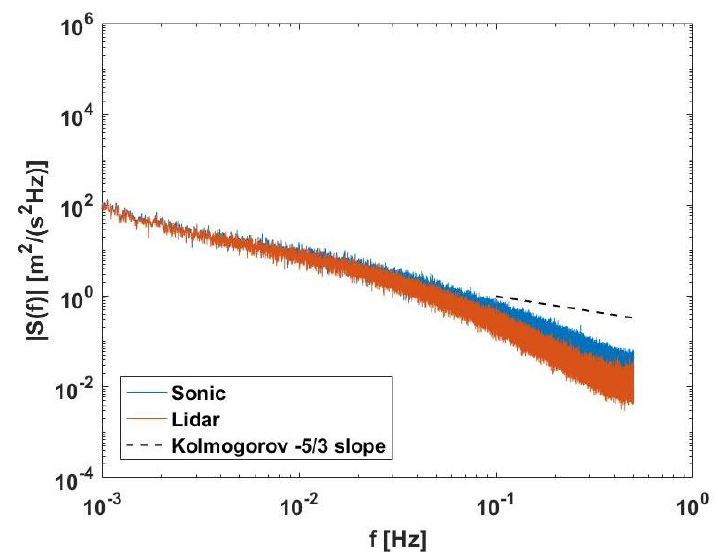
Figure 12. Power density spectra for the Lidar and the sonic anemometer, and the theoretical Kolmogorov